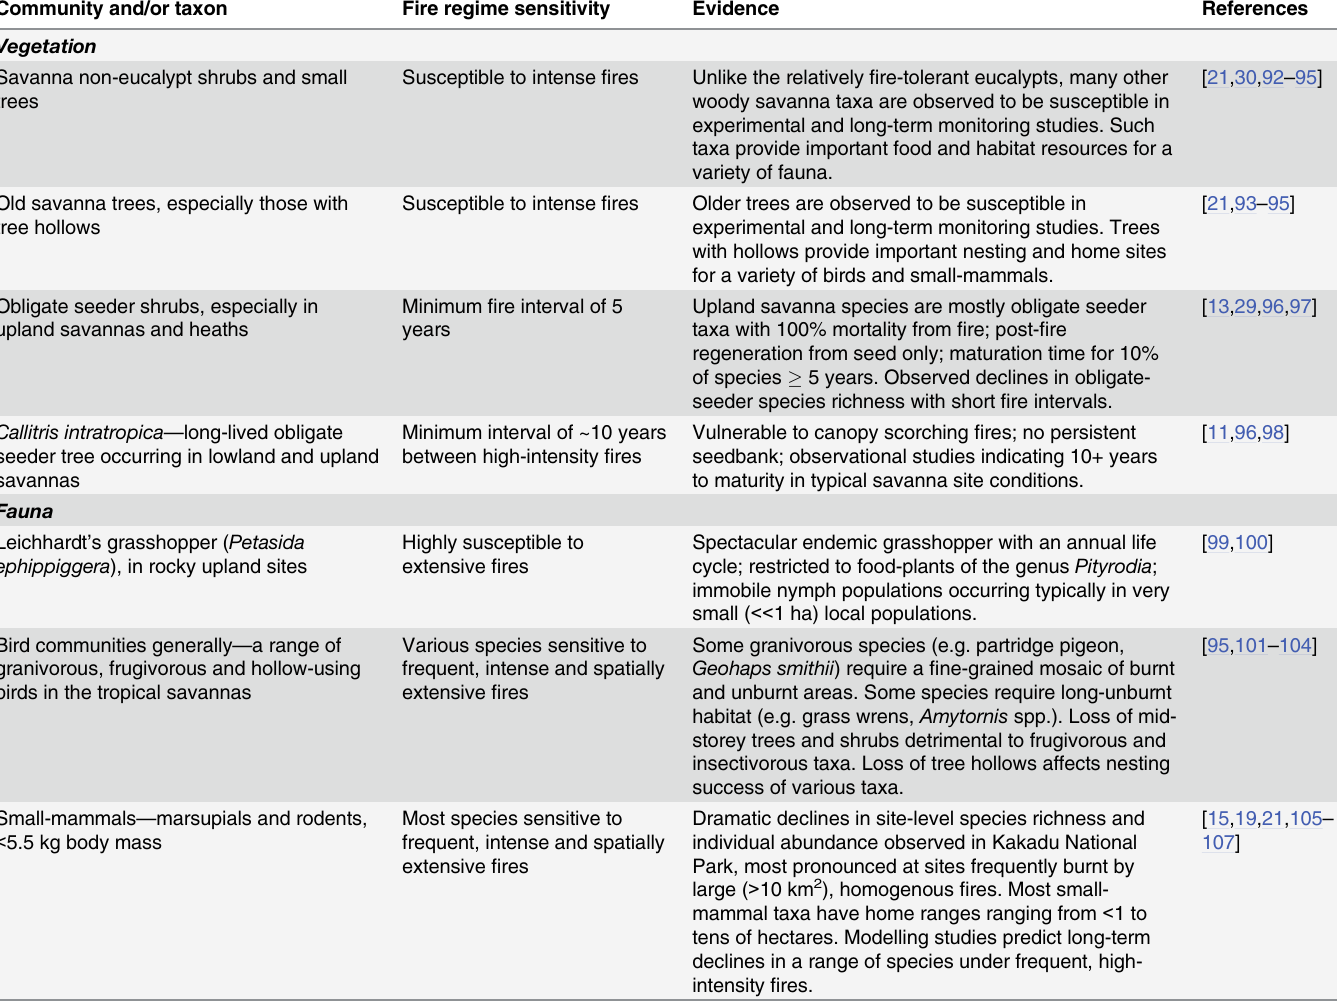
Table 1. Published evidence of the sensitivity of plant and animal communities (and component taxa) within the study region to fire regime